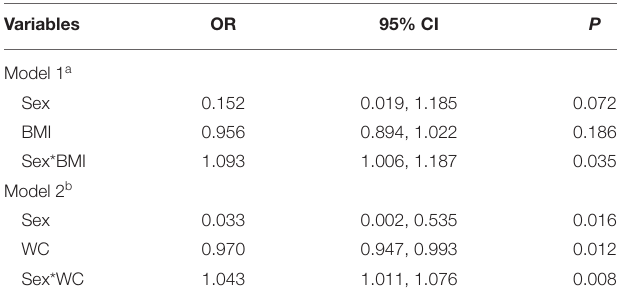
TABLE 6 | The interaction analysis between sex and BMI/ WC in multivariate logistic regression analysis.